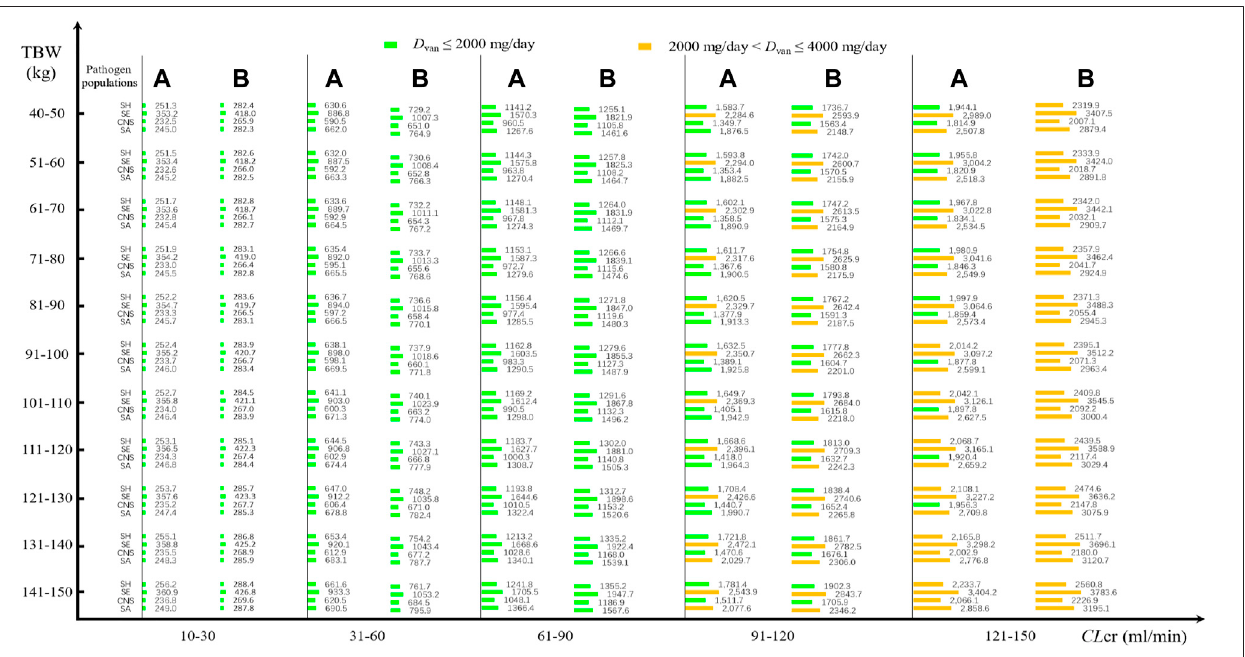
FIGURE3| VANdailydosesforpathogenpopulationswithapooledMICataCFRof90%basedonMCSs( N =5,000). (A) Dailydosedividedevery8 hfordifferent pathogen populations; (B) daily dose divided every 12 h for different pathogen populations.